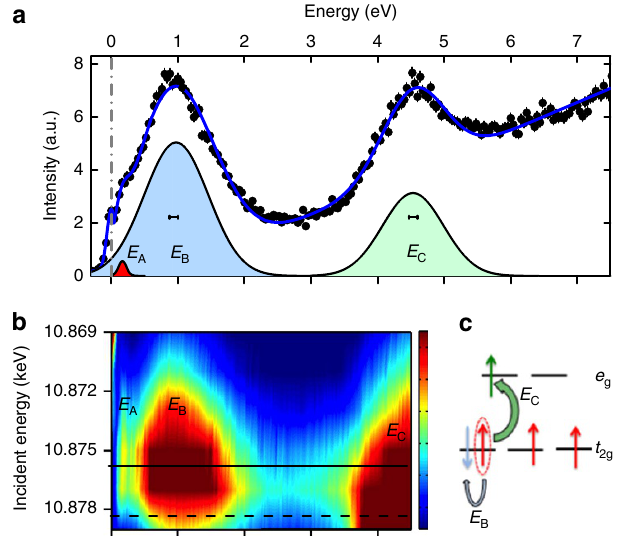
Figure 2 | Probing the electronic ground state of Cd 2 Os 2 O 7 with RIXS at the osmium L-edge. ( a ) Fixed incident energy photons of E i ¼ 10.877KeV, corresponding to the osmium resonant L 3 -edge, probe an inelastic energy loss spectrum out to 7.5eV (black dots). Three inelastic features are resolvable, E A ¼ 0.16(1)eV, E B ¼ 0.92(6)eV and E C ¼ 4.5(1)eV. The horizontal bars indicate the instrument resolution of 130meV (FWHM). The full RIXS spectrum was modelled with three Gaussians fitting the inelastic peaks E A , E B and E C , and a Gaussian for the elastic signal on top of a sloping background (blue line). ( b ) Varying the incident energy to follow the intensity dependence of the inelastic spectra reveals the maximum resonant intensity of E A and E B occur at the same incident energy of E i ¼ 10.8755(5)keV (solid line), whereas E C has a maximum at E i ¼ 10.879(1)keV (dashed line). The difference of the resonant energies reflects the splitting of the osmium d -manifold, nominally into t 2g and e g shells, and allows a categorization of the excitations as intra- t 2g ( E A and E B ) or t 2g (cid:2) e g ( E C ). ( c ) Schematic of the initial and final RIXS process. The initial electronic ground state before exciting an electron is indicated by the red spins in the limit of cubic CEF splitting of the 5 d manifold. The final RIXS states for E B (intra- t 2g ) and E C ( t 2g (cid:2) e g ) are indicated by the blue and green spins, respectively. All measurements were performed at 60K at q ¼